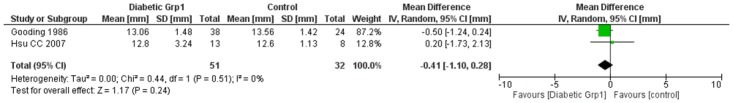
Meta-analysis and forest plot for sub-metatarsal head 3 unloaded total soft tissue depth, non-diabetic and diabetic group 1.